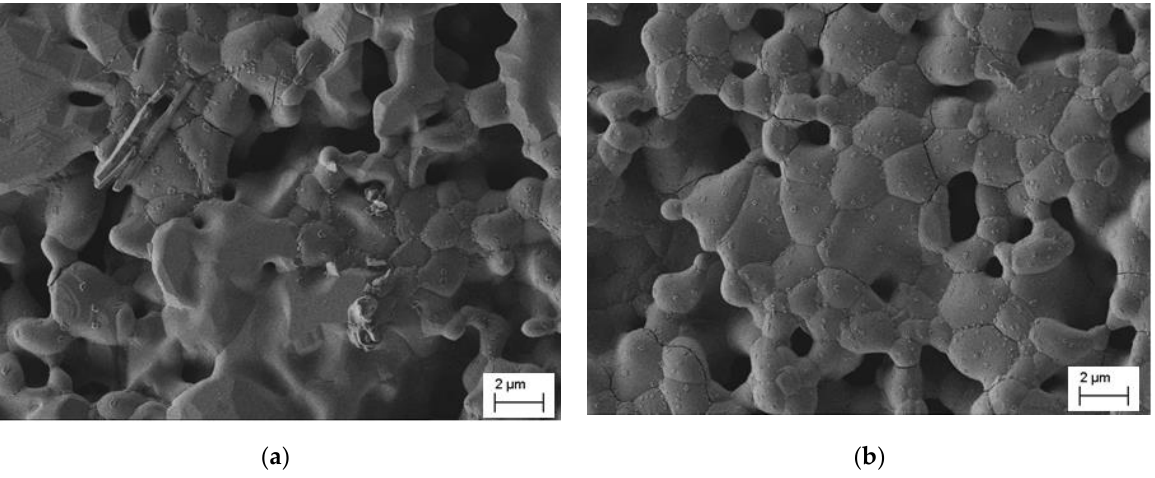
Figure 2. SEM images for undoped ( a ) and Eu 3+ -doped ( b ) BaGa 2 O 4 ceramics.